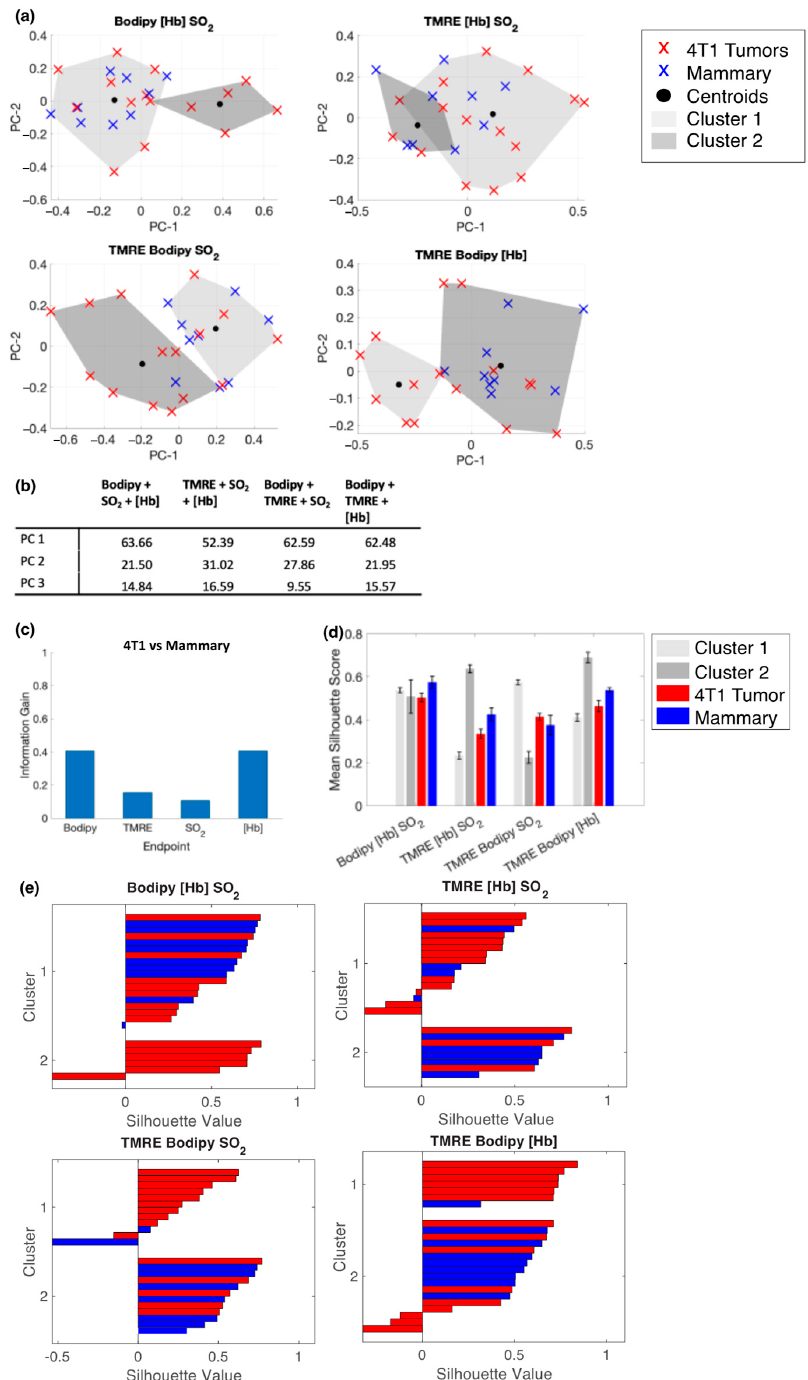
Figure 7. Bodipy FL C16 and TMRE fluorescence measurements combined with extracted vascular parameters separate clusters of normal and 4T1 tumor tissue. ( a ) Projections of the first two PCs show spectral clustering results for four different combinations of the following endpoints: Bodipy FL C16 fluorescence intensity, TMRE fluorescence intensity, total hemoglobin concentration ([Hb]), and total oxygen saturation (SO 2 ). Fluorescence intensity is reported as the average intensity within 2.5 nm of the emission peak. ( b ) Table containing the variance described by each PC, by endpoint combination. ( c ) The calculated information gained from each variable. ( d ) The mean silhouette scores for cluster 1, cluster 2, data points with a true label of 4T1 tumors, and data points with a true label of healthy mammary tissue. Error bars are SE. ( e ) Silhouette plots for each endpoint